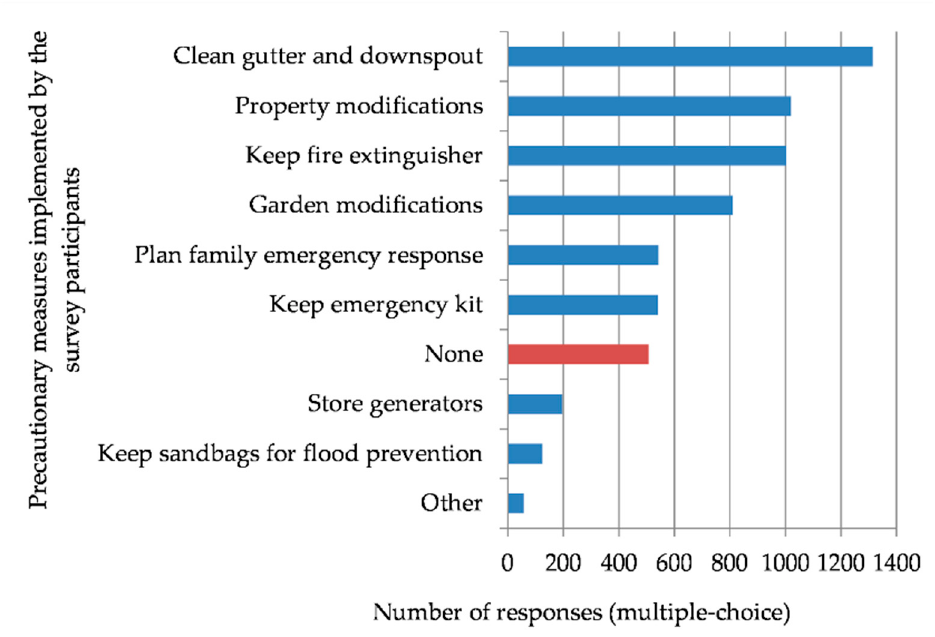
Figure 8. Frequency of adoption of prevention measures at property.